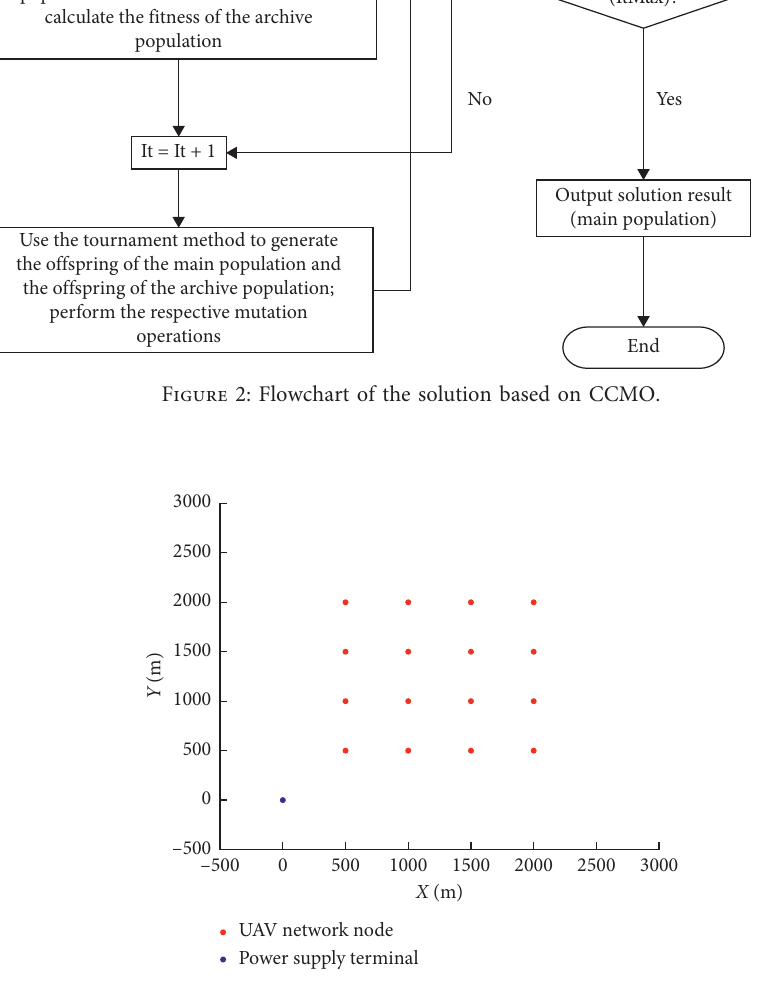
Figure 3: X - Y plane coordinates of UAV network nodes and the power supply